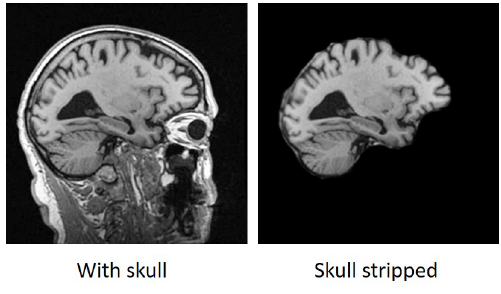
Figure 2. Sample brain MR images with skull and without